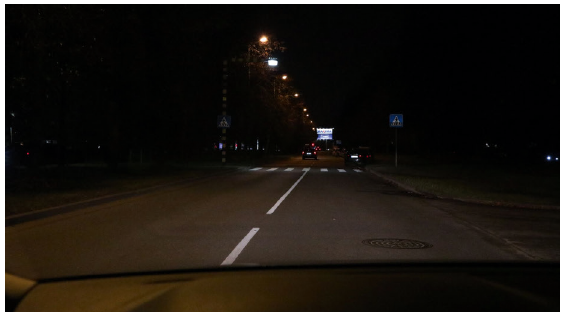
Figure 5. Pedestrian crossing with additional